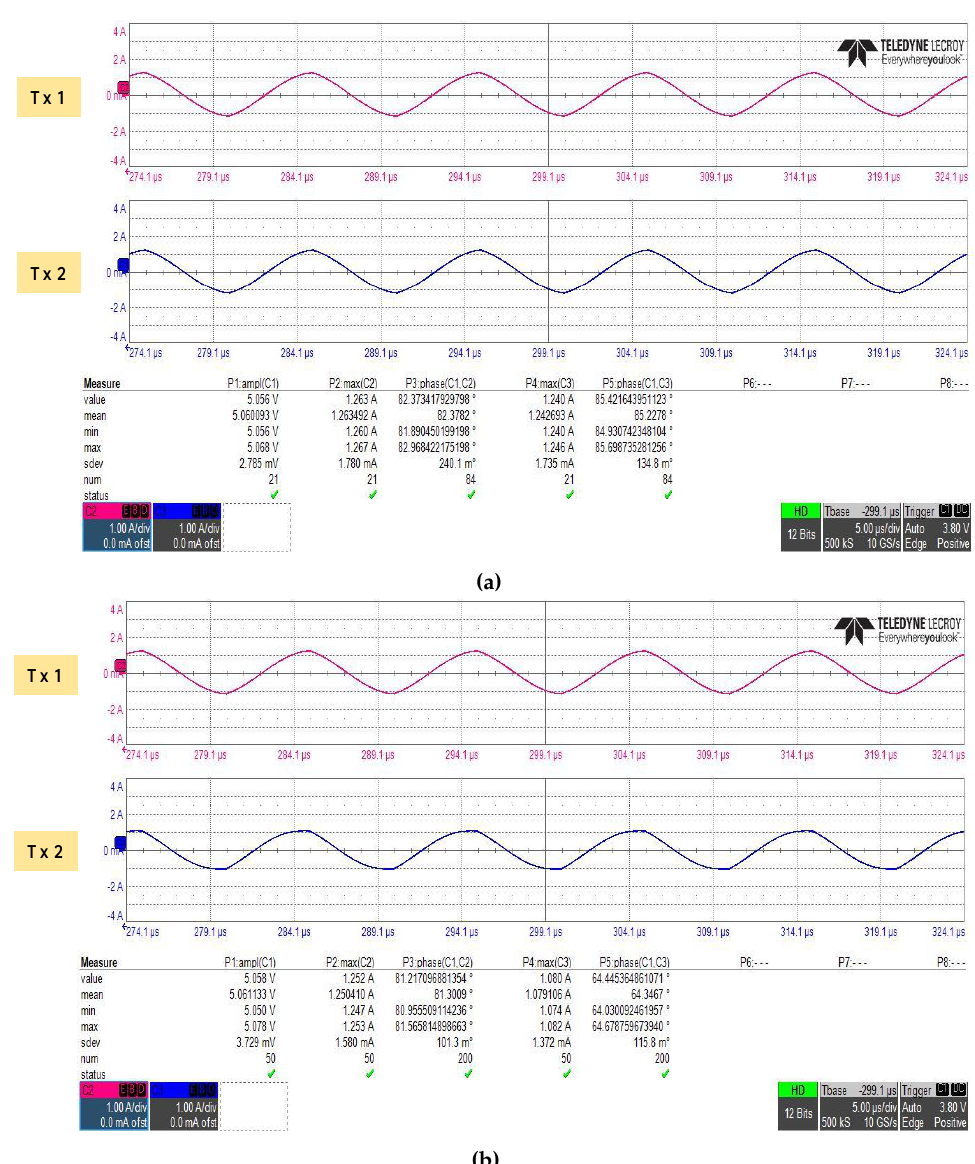
Figure 7. Measurement of the current of Tx 1 and Tx 2. ( a ) When there is no Rx coil. ( b ) When Rx 1 is placed on Tx